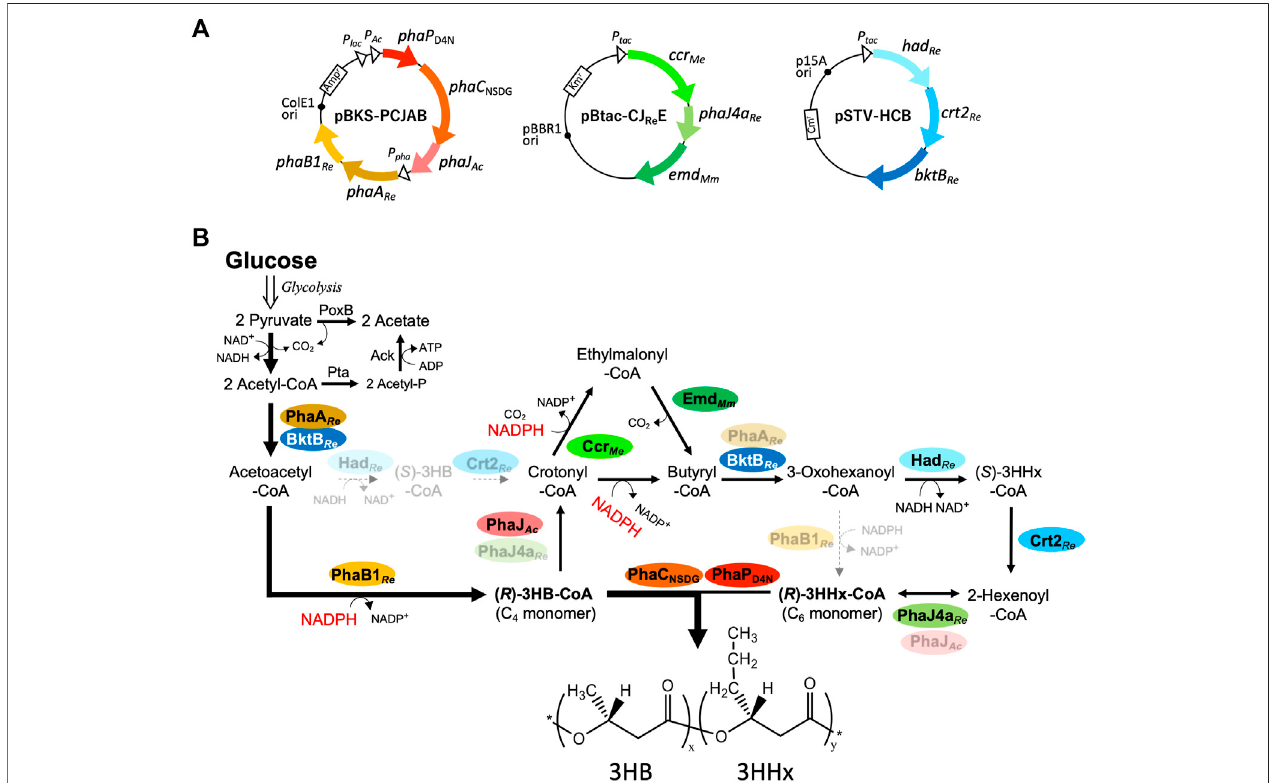
FIGURE1| Plasmids (A) andarti fi cialpathways (B) introducedinto E.coli forbiosynthesisofP(3HB- co -3HHx)from glucose.PhaP D4N ,D4Nmutantofphasinfrom A. caviae; PhaC NSDG , N149S/D171G mutant of PHA synthase from A. caviae ; PhaJ and PhaJ4a, ( R )-enoyl-CoA hydratases; PhaA and BktB, β -ketothiolases; Ccr, crotonyl-CoA carboxylase/reductase; Emd, ethylmalonyl-CoA decarboxylase (codon-optimized); Had, NAD-( S )-3HB-CoA dehydrogenase, Crt2, crotonase; Pta, phosphate acetyltransferase; Ack, acetate kinase; PoxB, pyruvate oxidase. Ac , Aeromonas caviae ; Re , Ralstonia eutropha ; Me , Methylorubrum extorquens ; Mm , Mus musculus